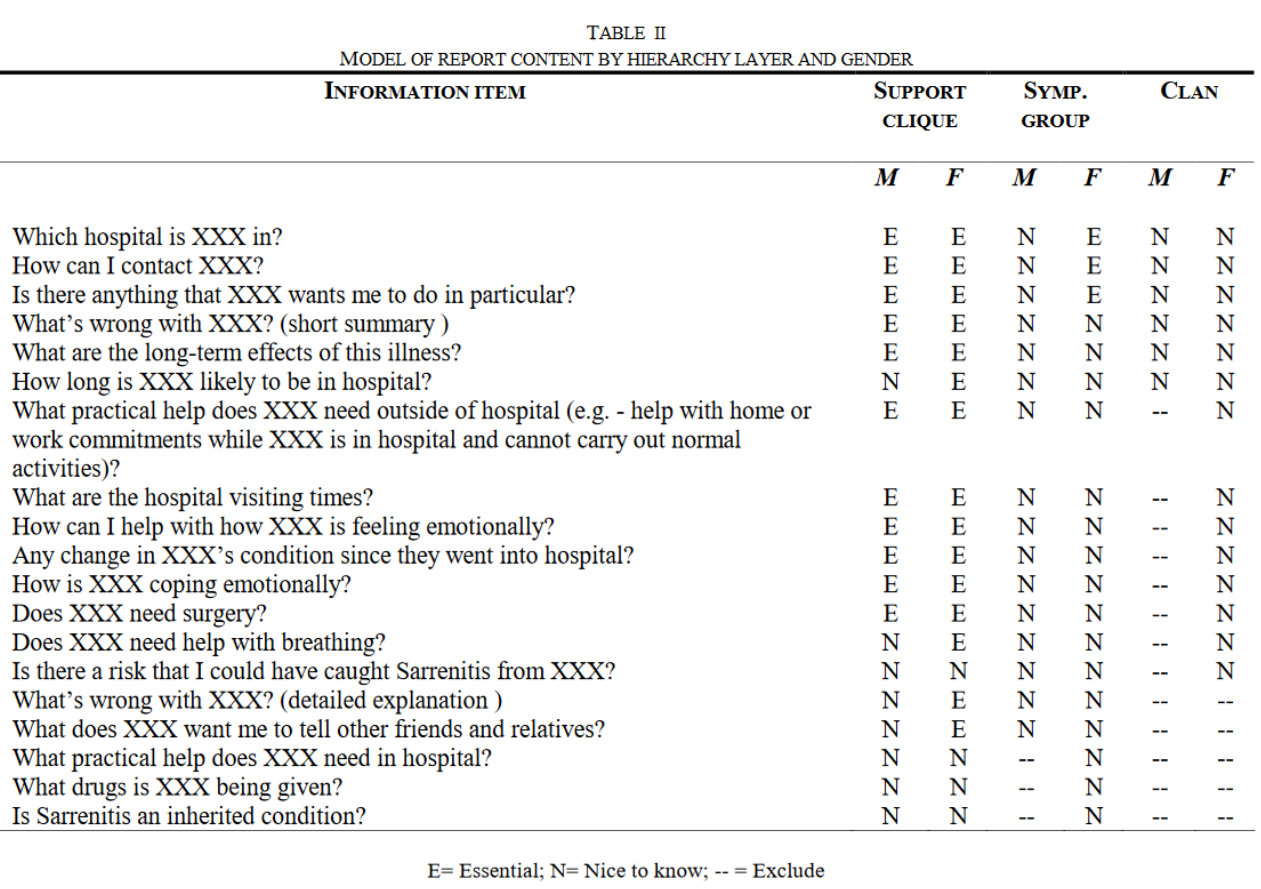
Figure 2. Examplequestions/scenarios(A3)from[33]